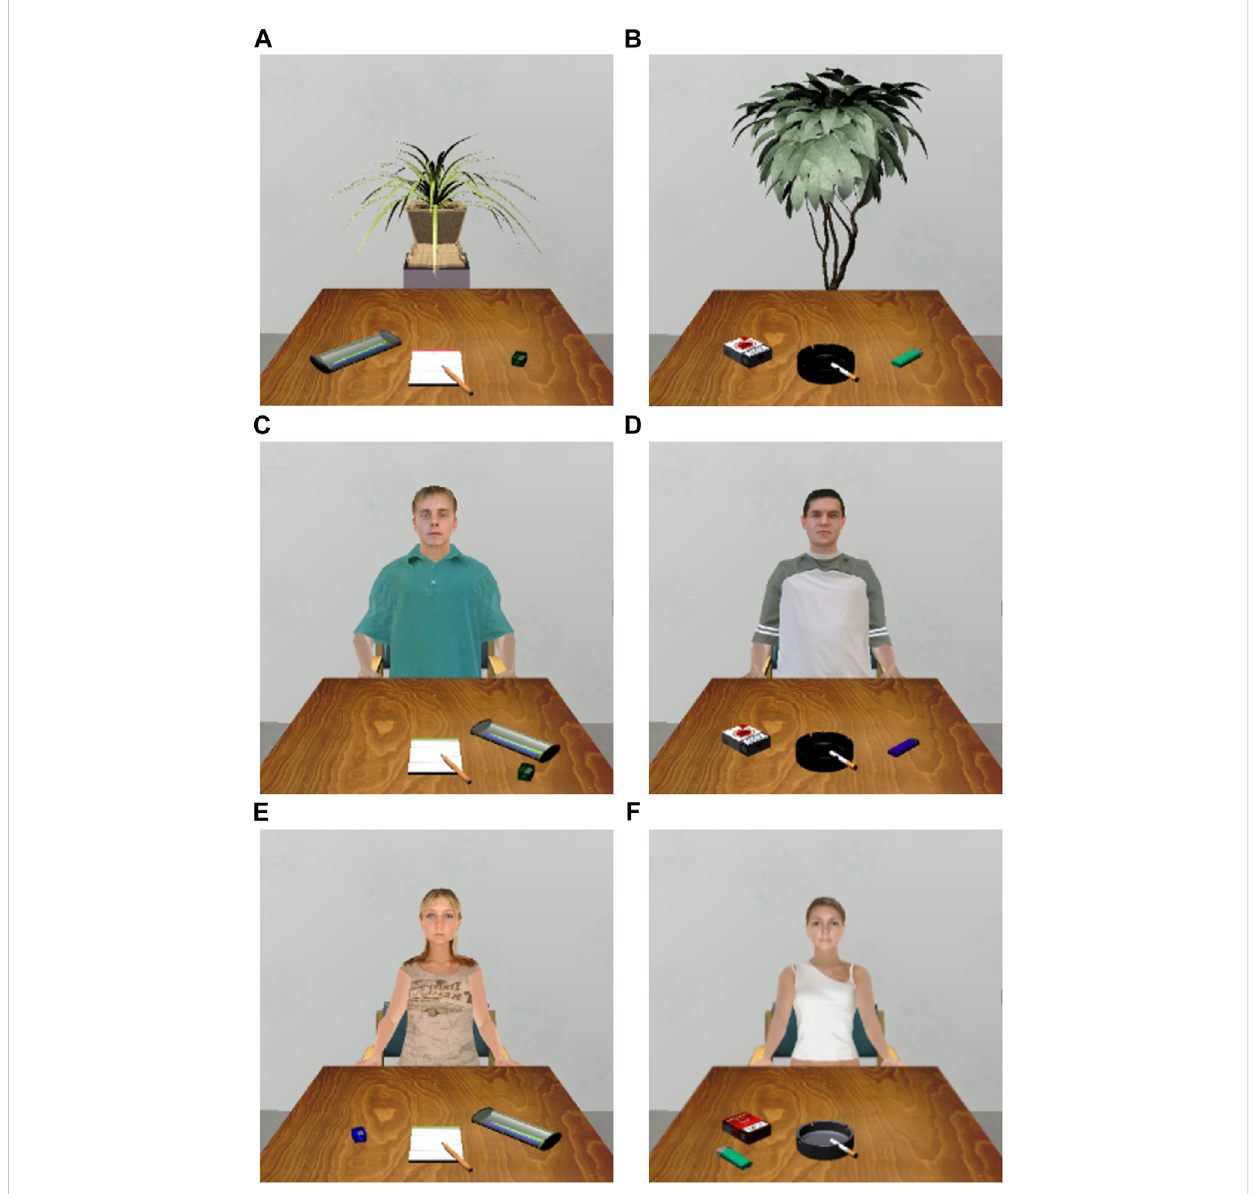
FIGURE 3 Examplesofthefourstimulusconditionsusedinthestudy(maleandfemaleversions). (A) Neutralstimuliinaneutralcontext. (B) Smokingstimuliina neutralcontext. (C) Neutralstimuliinasocial context(maleversion). (D) Smokingstimuliinasmokingcontext(maleversion). (E) Neutralstimuliinasocial context (female version). (F) Smoking stimuli in a social context (female